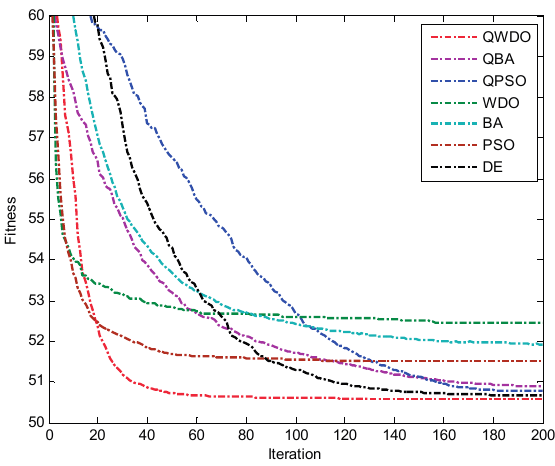
Figure 9. Fitness of the first instance for D = 10.